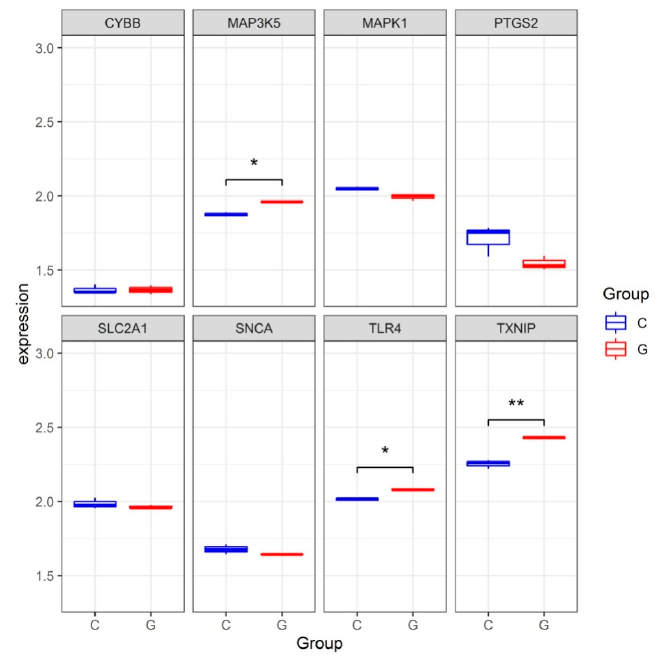
Figure 5. The expression levels of hub genes in the gene expression dataset GSE13011. * p < 0.05, ** p <